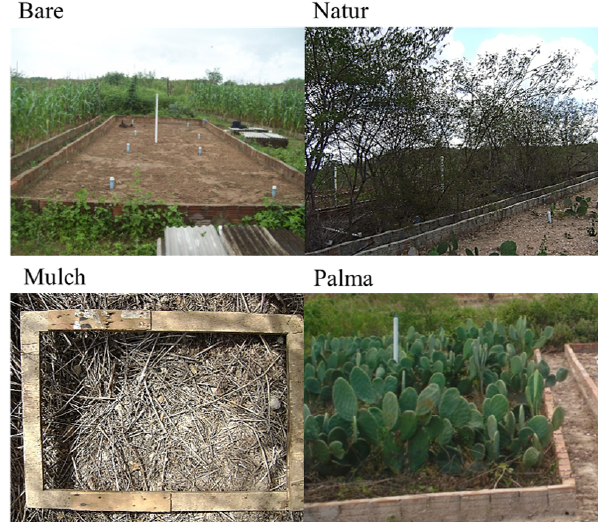
Figure 3. Photographs of the adopted soil cover treatments: bare soil; mulch cover; cactus barriers, and Natural Caatinga